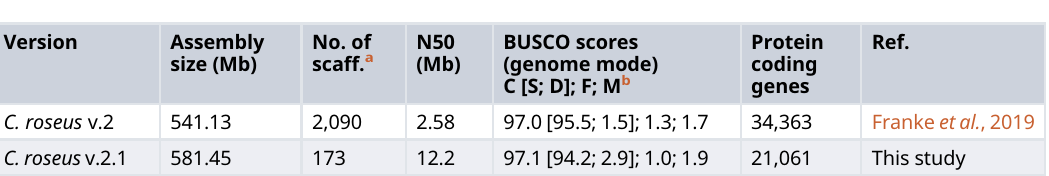
Table 1. Genome assembly